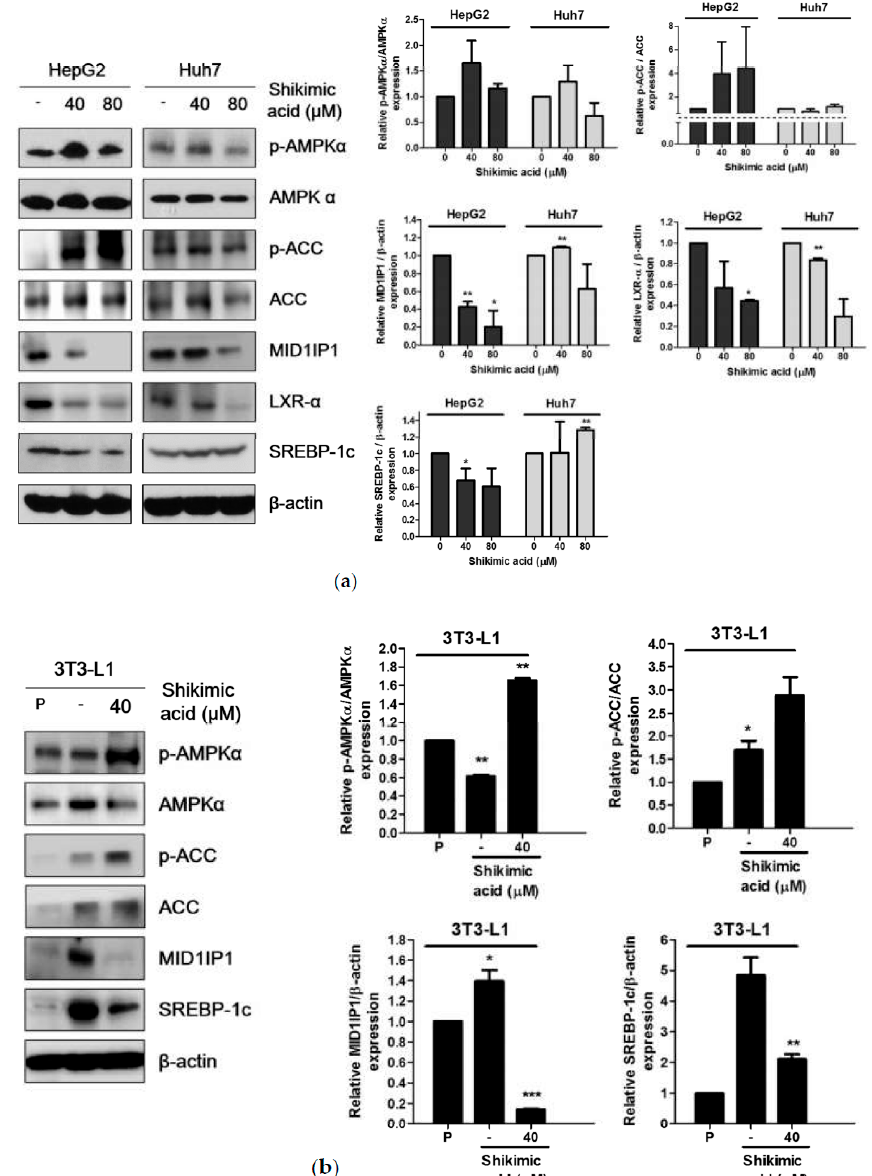
Figure 4. Effect of shikimic acid on lipid metabolism related molecules in HCC and 3T3-L1 cells. Lipogenesis-related proteins were evaluated by Western blotting after treatment of shikimic acid for 24 h in HCCs ( a ) and 3T3-L1 preadipocytes and adipocytes ( b ). P: Preadipocyte. All experiments were independently performed at least three times. * p < 0.05, ** p < 0.01, *** p < 0.001.